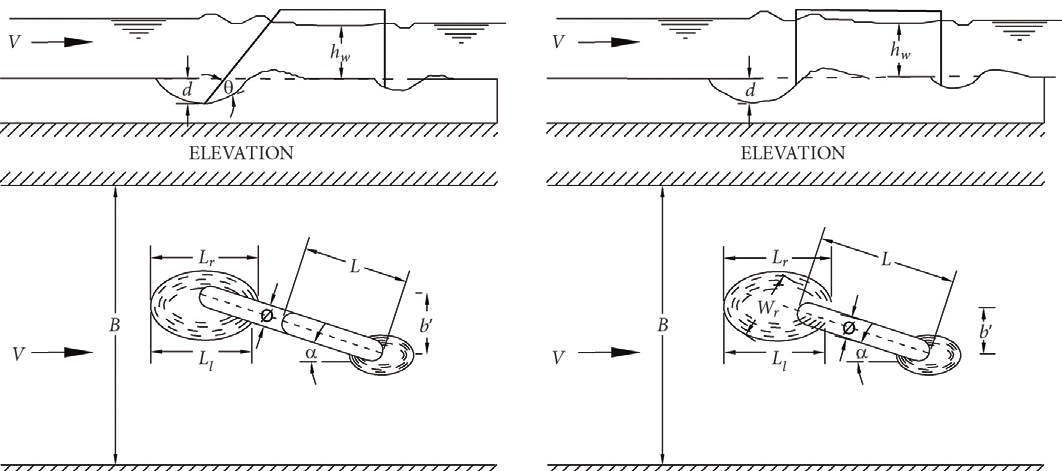
Figure 2. Schematic diagram of parameter representation measured in each experiment, initially presented by Habib